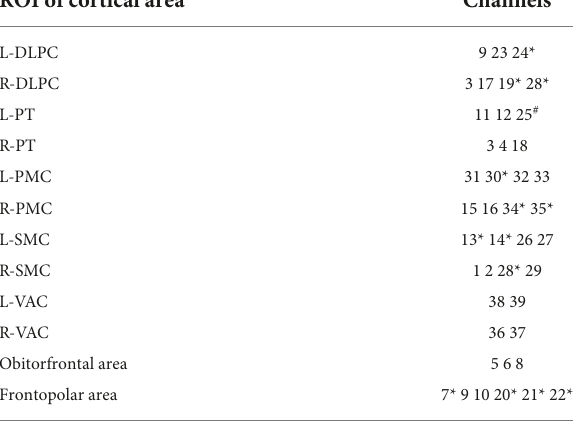
TABLE 2 Channels with HBO significantly increased when compared with the resting baseline during FNS.